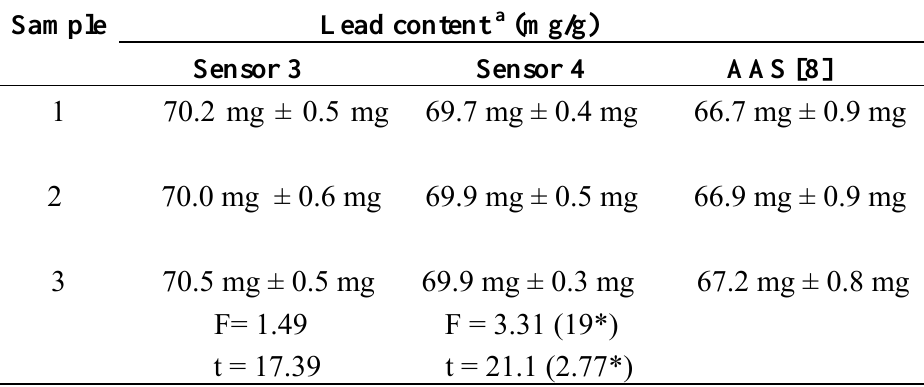
Table 5. Determination of lead in solder alloy by using potentiometric sensors and atomic absorption spectrometry (AAS)